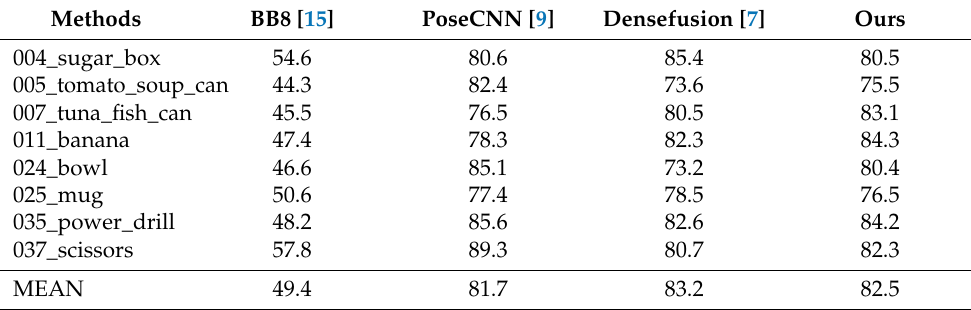
Table 1. Comparison of ADD values of 6D pose estimation in the YCB-Video